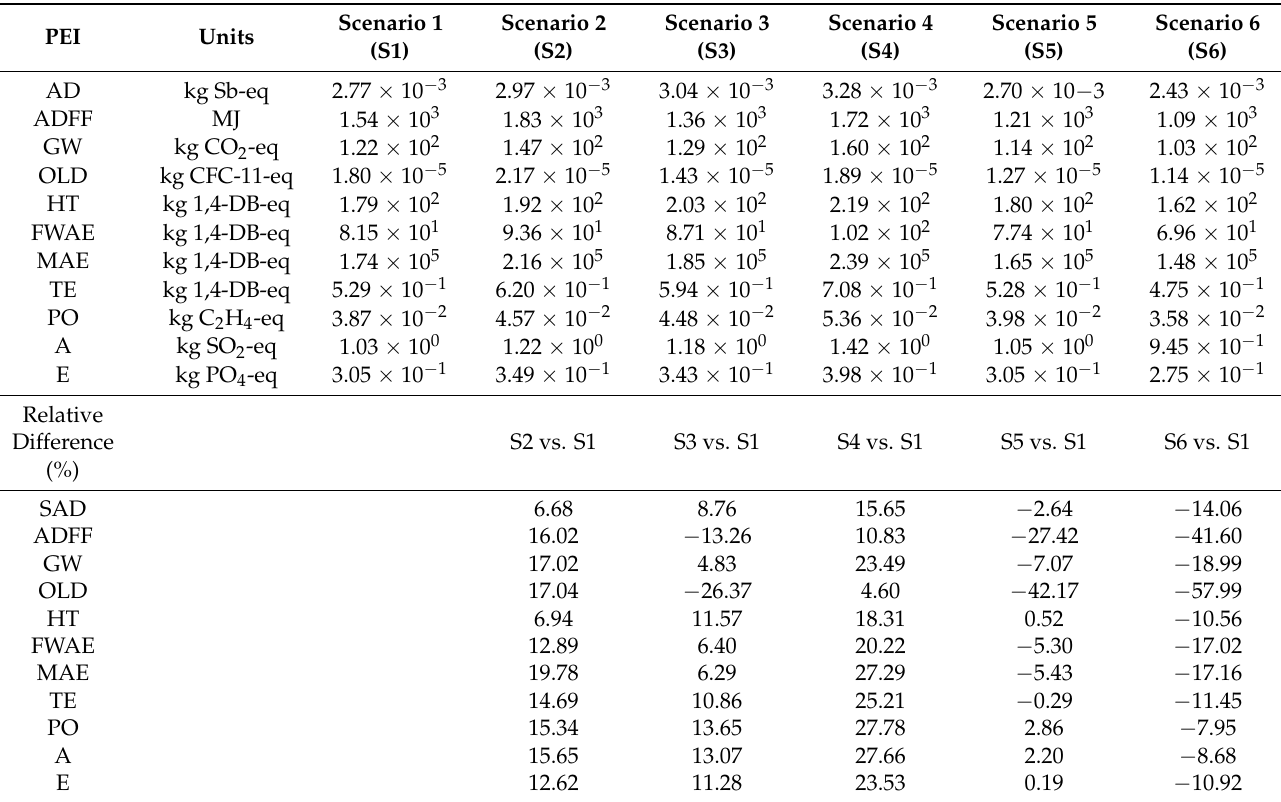
Table 7. Values of the potential environmental impacts (PEI) in the scenarios analyzed (Table 3) and the relative difference (RD) between the current scenario (S1) and those proposed